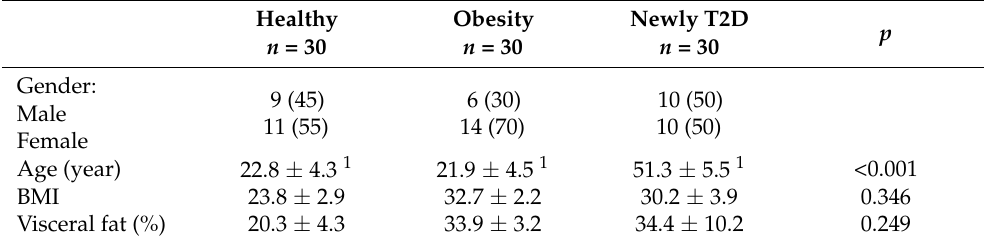
Table 1. Anthropometric characteristics.